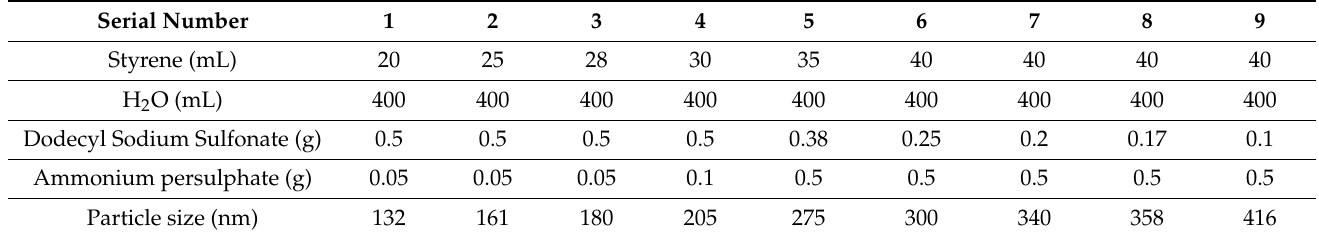
Table 3. Emulsion polymerization formula and corresponding particle